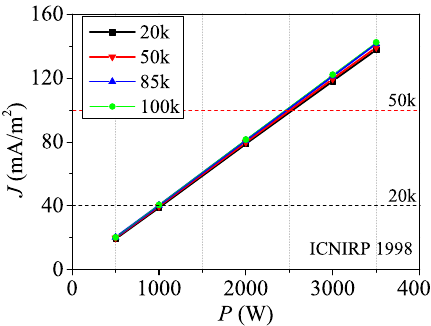
Figure 8. Curves of the surface current density of the human body versus the output power at various